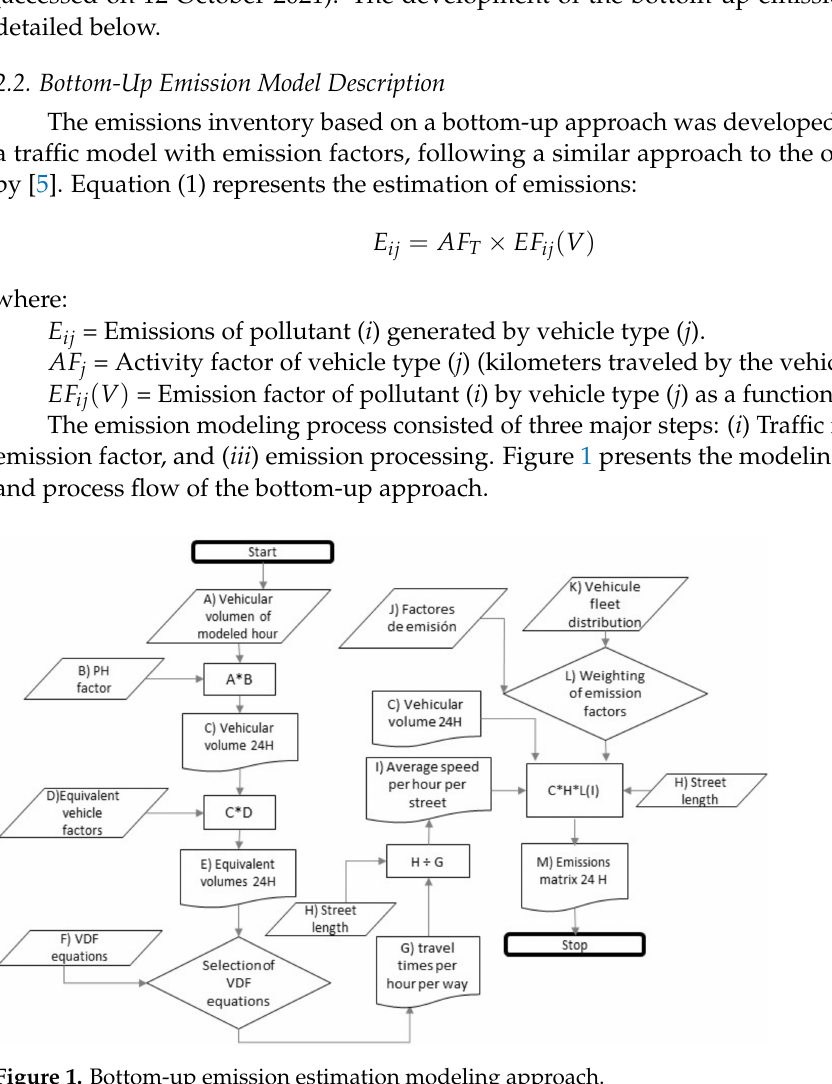
Figure 1. Bottom-up emission estimation modeling